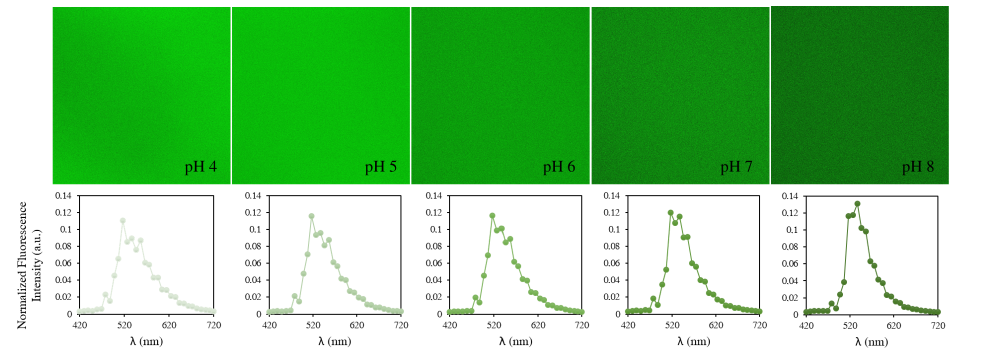
Figure 5. Fluorescence images of BCECF in DMEM medium from pH 4.0 (left) to pH 8.00 (right) under 405 nm excitation. For each pH, we present the average emission spectrum over the entire image (2048 × 2048